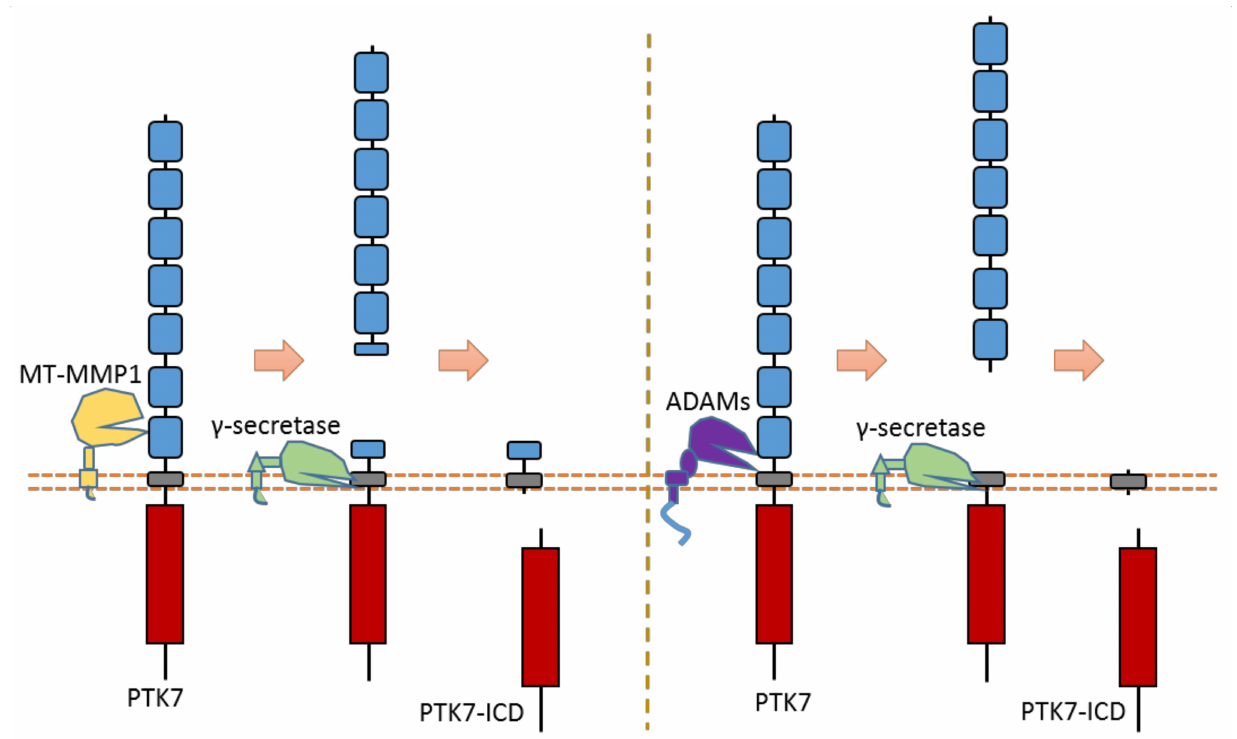
Figure 14. Schematic illustration of proteolytic cleavage in